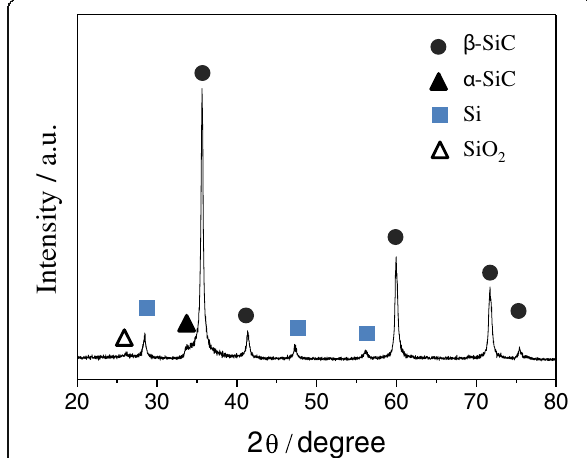
Fig. 4 XRD profile of Si-SiC composite nanoparticles prepared by non-transferred arc thermal plasma process